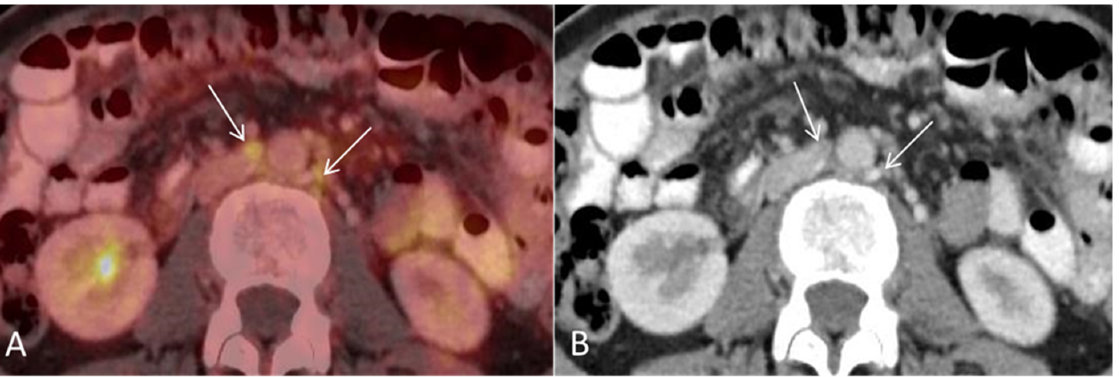
Figure 4. ( A ) Baseline axial PET/CT fused and ( B ) axial CT shows several non-enlarged retroperito- neal lymph nodes with high metabolic activity ( A , B , arrows). The lymph nodes were not suspicious for malignancy on CT alone.